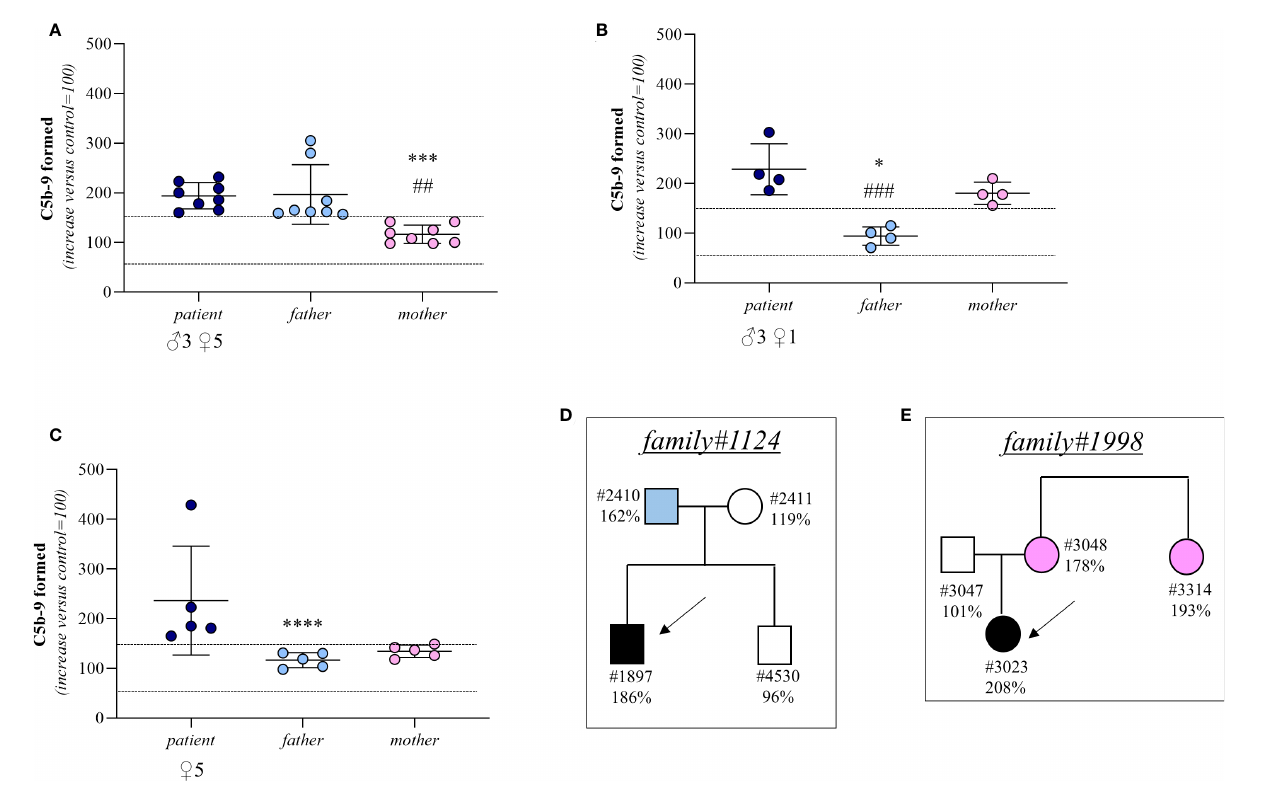
FIGURE 5 C5b-9 formation on activated HMEC-1 induced by serum from aHUS patients without identi fi ed mutations and from their parents. (A – C) Endothelial surface area covered by C5b-9 staining after 2h incubation of ADP-activated HMEC-1 with serum (diluted 1:2 in test medium) from aHUS patients without identi fi ed mutations (remission, n=16; acute, n=1) and their parents. Dotted lines are upper and lower limits of normal range. Results are shown as fold increase of stained surface area after incubation with serum from aHUS patients and their parents versus control pool of sera run in parallel. Points represent fold increase values of single subjects. Horizontal bars are mean ± SD values. *P<0.001, ***P<0.01, ****P<0.05 vs patient; ##P<0.01, ###P<0.05 vs other parent. (D) Pedigree #1124 of patient #1897 without identi fi ed mutations. (E) Pedigree #1998 of patient #3023 without identi fi ed mutations. Arrows indicate probands, affected individuals are in black. The circles indicate female subjects and the squares male